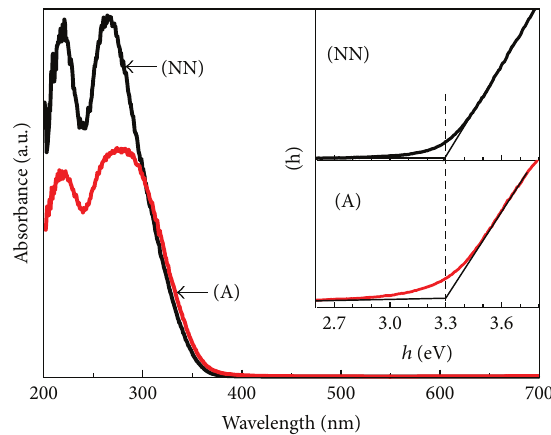
Figure 3: Diffuse reflectance spectra of NN and A. The insets are the plots used to estimate the band gap.